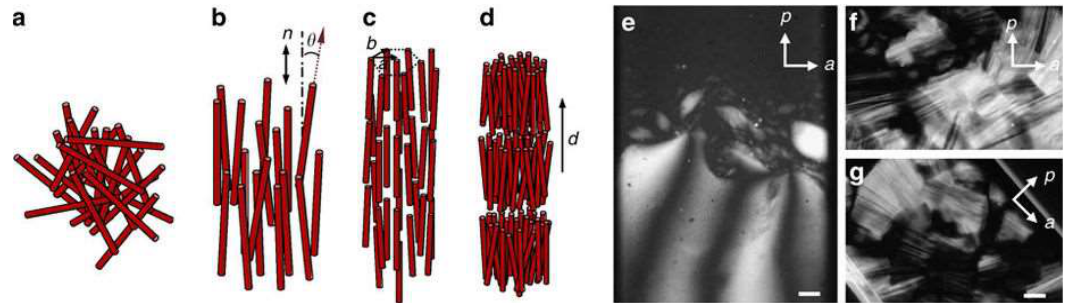
Figure 3. Schemes of ( a ) isotropic, ( b ) nematic, ( c ) columnar, and ( d ) smectic phases in imogolite suspensions. Photographs of ( e ) both isotropic and nematic phases in sedimented spindle-shaped nematic droplets; and ( f , g ) the columnar phase, obtained with single-walled Si – imogolite nanotube (INT) suspensions. Scale bar, 200 mm. Adapted from